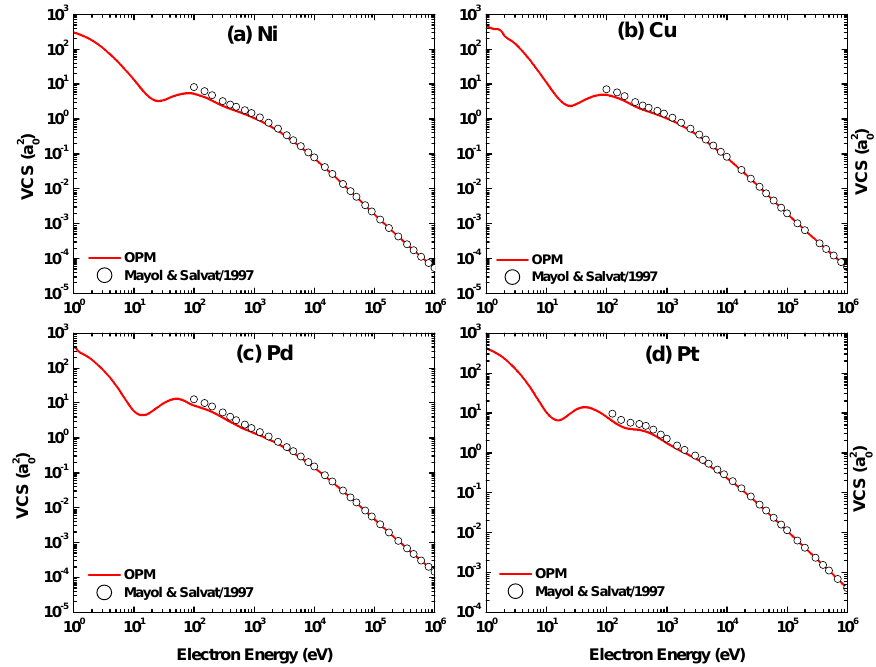
Figure 33. The present OPM calculations of the viscosity cross-section (VCS) for electron impact scattering from ( a ) Ni 58 , ( b ) Cu 63 , ( c ) Pd 108 , and ( d ) Pt 196 in comparison with the Dirac–Hartree–Fock (DHF) calculations of Mayol and Salvat [58].